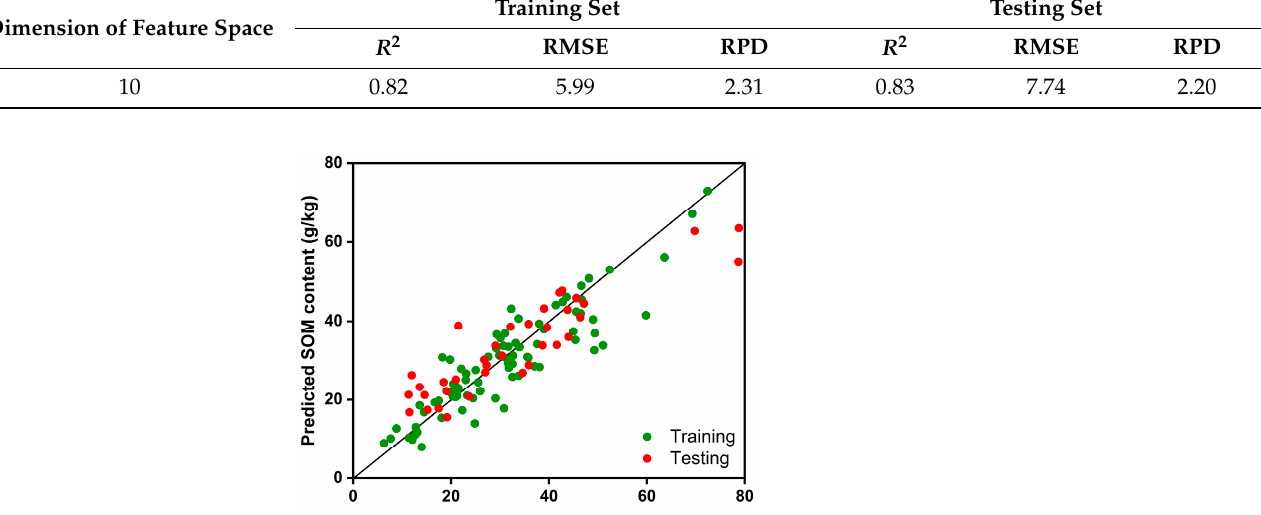
Table 5. The predictive performance of PLSR models built with PCA algorithm.